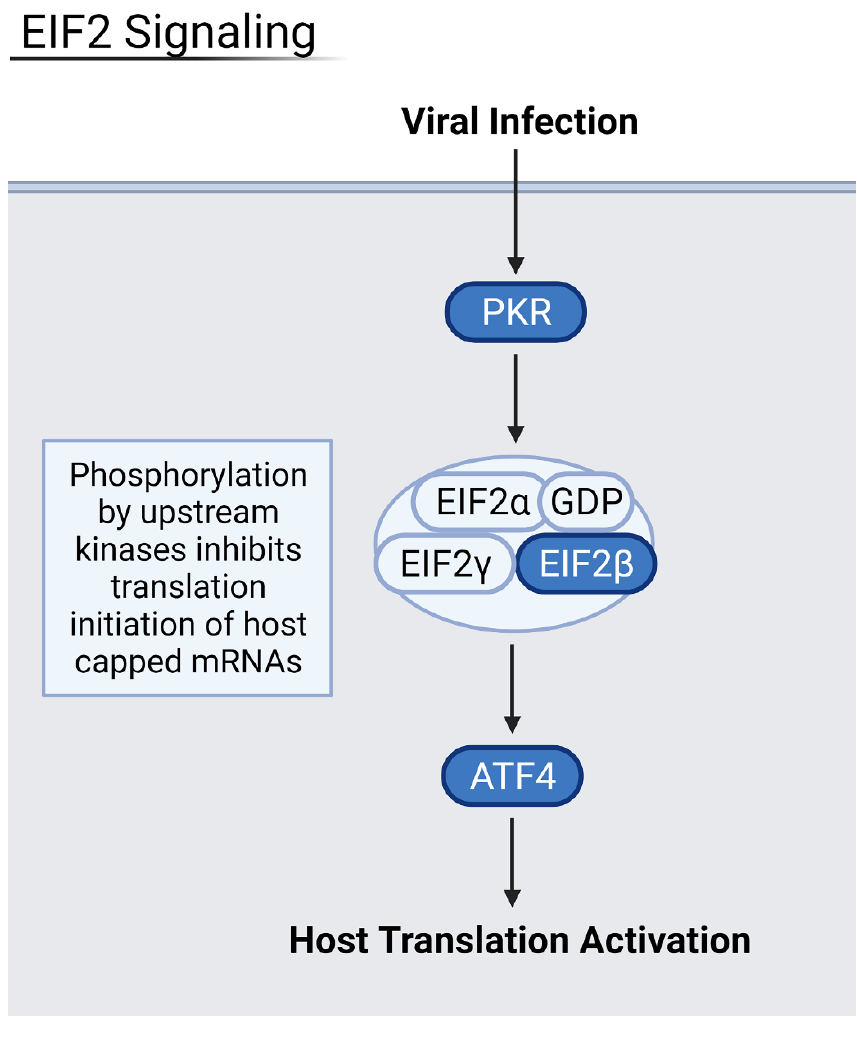
Figure 5. Summary of the eIF2 pathway where blue proteins are downregulated. Samples from severely infected heart, kidney, and liver shared these downregulated kinases and transcription fac- tors, leading to an overall decrease in host translation of inflammation-inhibiting factors. Generated in Biorender.